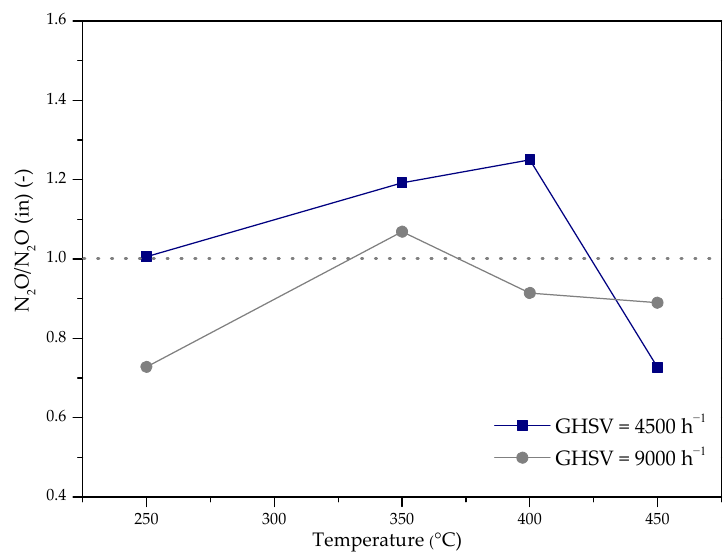
Figure 7. N 2 O/N 2 O (in) ratio as a function of temperature and catalyst load for H-Clin.